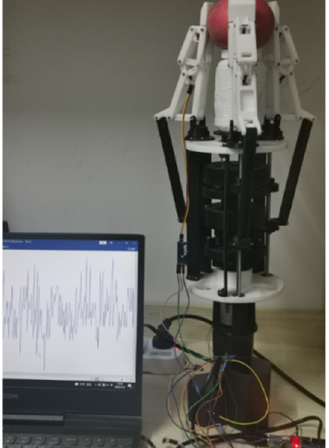
Figure 18. Contact force of the second and third knuckles when grasping the cylinder.